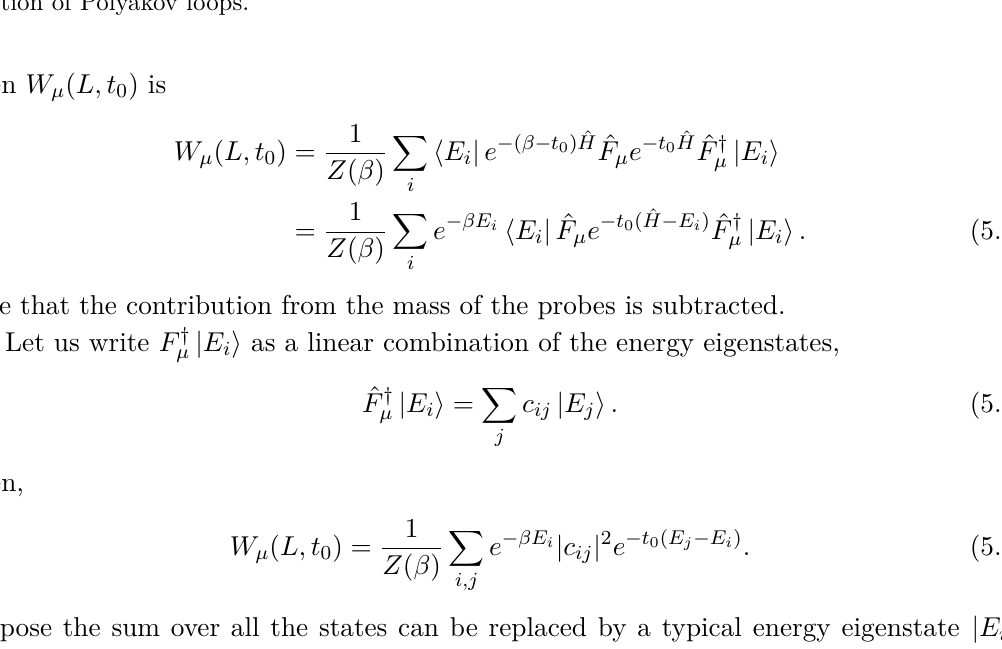
Figure 5. Temporal Wilson loop W µ ( L, β ) . Such a Wilson loop is equivalent to the two-point function of Polyakov